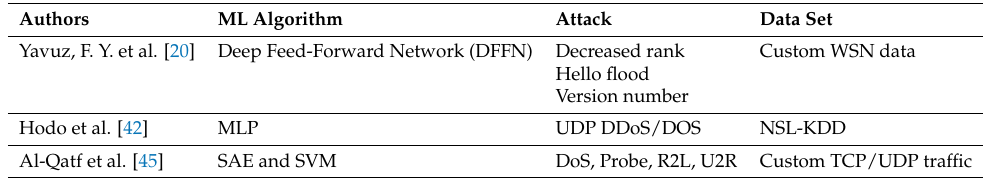
Table 4. Related work using ML models on RPL and DODAG attacks.